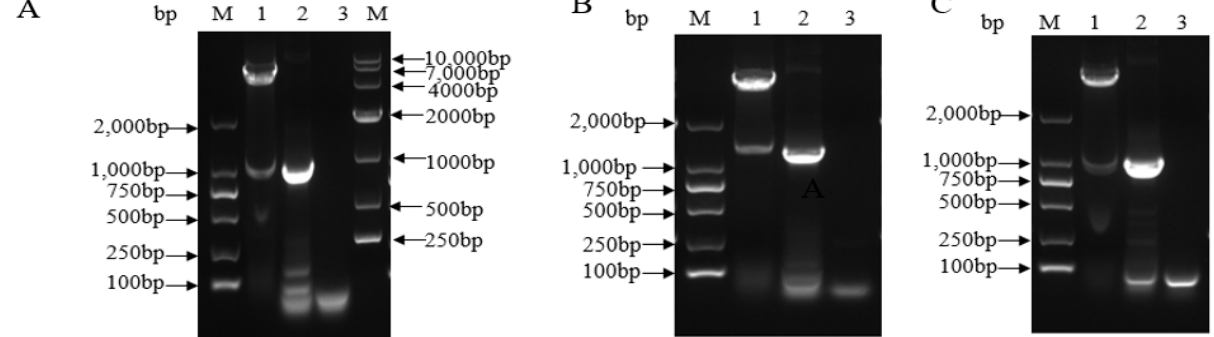
Figure 2. The image shows the DNA bands after Agrose gel electrophoresis; PCR amplification and restriction endonucle- ase digestion of His-SUMO-VP1 and VP0 in plasmid DNA. ( A ) Identification by PCR and double digestion of recombinant plasmid pET-32a- His-SUMO-VP1; lane 1: Double digestion product of pET-32a-HisSUMO-VP1; lane 2: PCR product; lane 3: Negative control; ( B ) Identification by PCR and double digestion of recombinant plasmid pET-32a- His-SUMO-VP0;